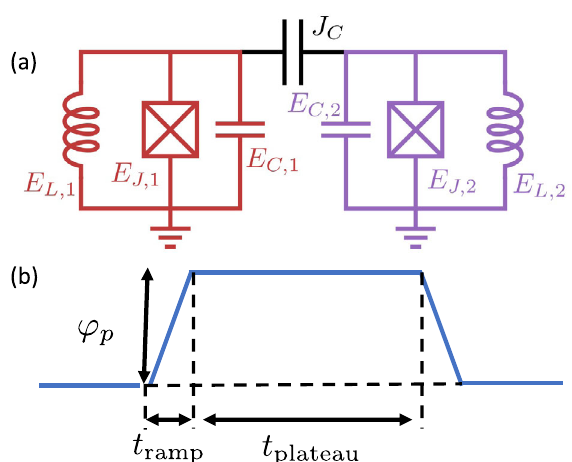
Fig. 2 Device and control parameters optimized for the iSWAP gate. a Circuit diagram of two fl uxonium qubits coupled by a capacitor. Each circuit component corresponds to a term in the Hamiltonian, and we label the components with their energy parameters. The capacitive coupling strength J C is determined by the capacitance of each qubit and between these two qubits. b Time-dependent part of the control pulse shape. It corresponds to the second term on the right-hand side in Eq.